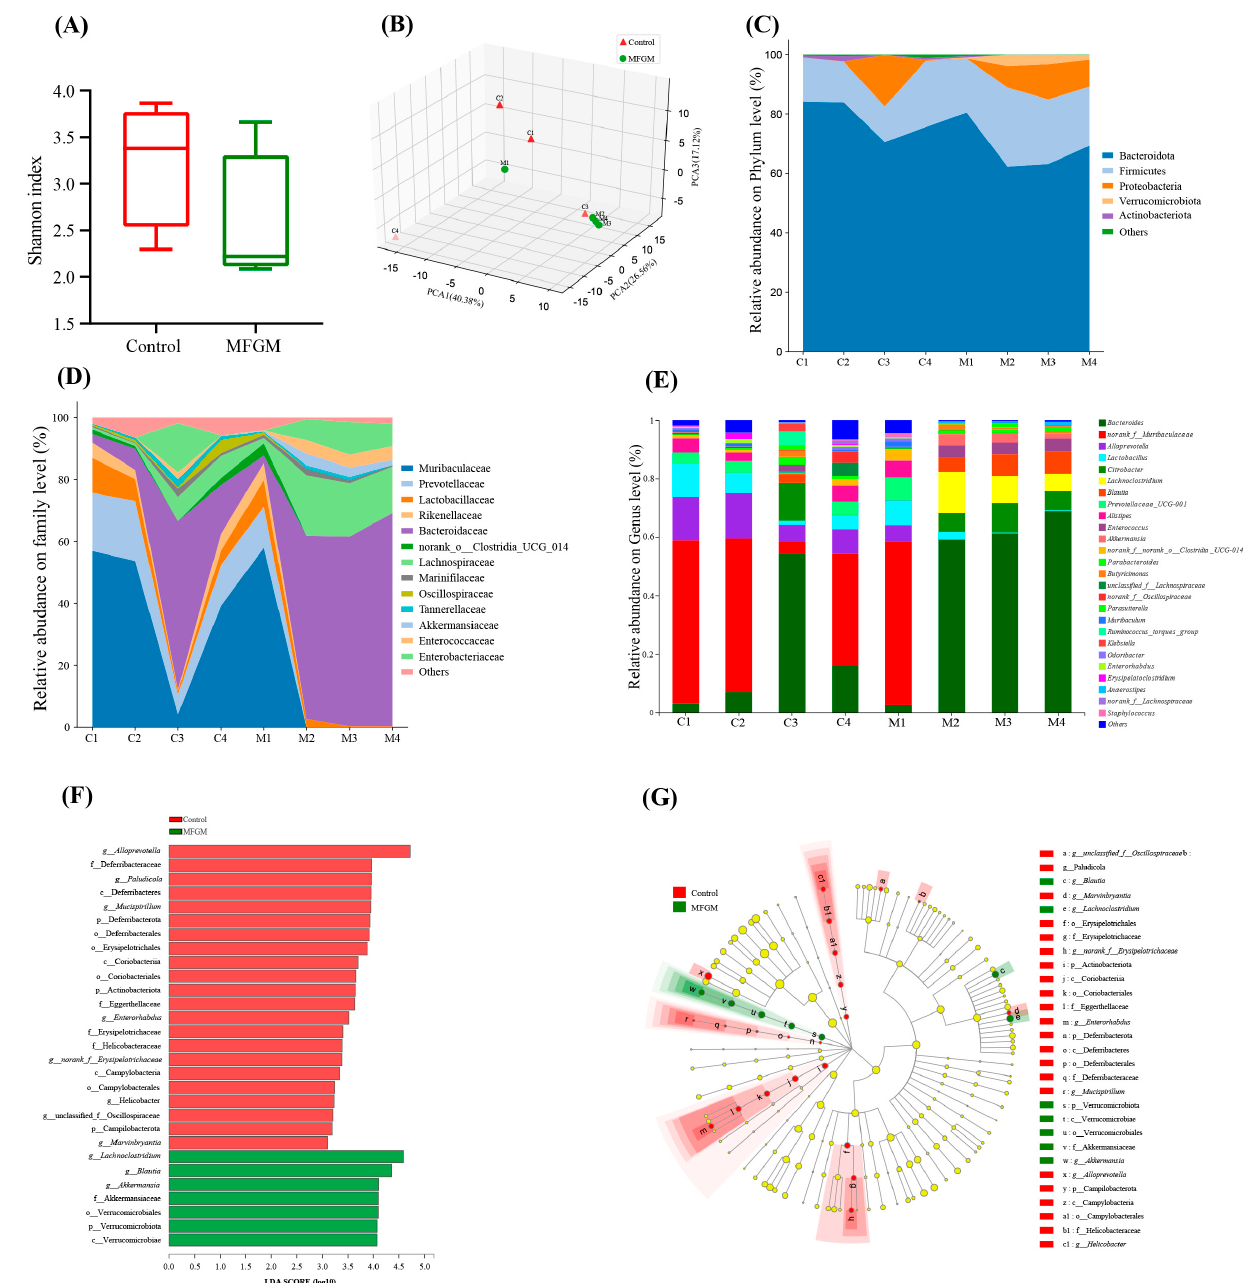
Figure 5. Effects of milk fat globule membrane on intestinal flora at 18 weeks: ( A ) Alpha-diversity was assessed by calculating the Shannon index; ( B ) beta-diversity was assessed using principal component analysis; ( C ) effects of milk fat globule membrane on the composition of gut microbiota in the mice (Phylum level); ( D ) effects of milk fat globule membrane on the composition of gut microbiota in the mice (Family level); ( E ) effects of milk fat globule membrane on the composition of gut microbiota in the mice (Genus level); ( F ) results of linear discriminative analysis (LDA); and ( G ) effect size (LefSe) analysis between the two groups. Cardiogram showing differentially abundant taxonomic clades with an LDA score of 3.0 among groups with a p -value of 0.05; C1, C2, C3, and C4 belong to the Control group, whereas M1, M2, M3, and M4 belong to the MFGM group. Control: fed with saline; MFGM: fed with 400 mg/kg BW milk fat globule membrane.